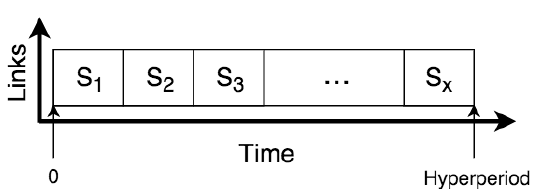
Figure 2. Example of schedule composed by multiple